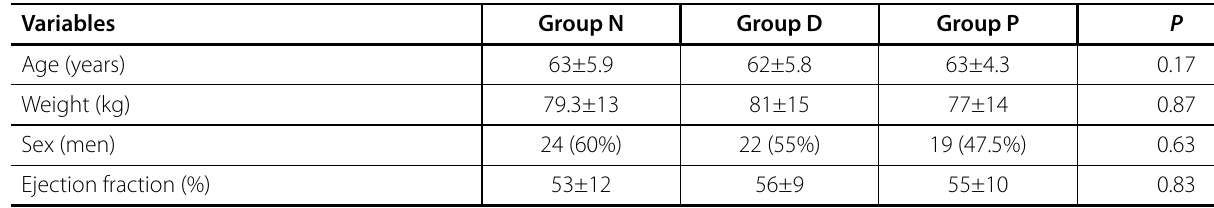
Table 1 . Patient characteristics.